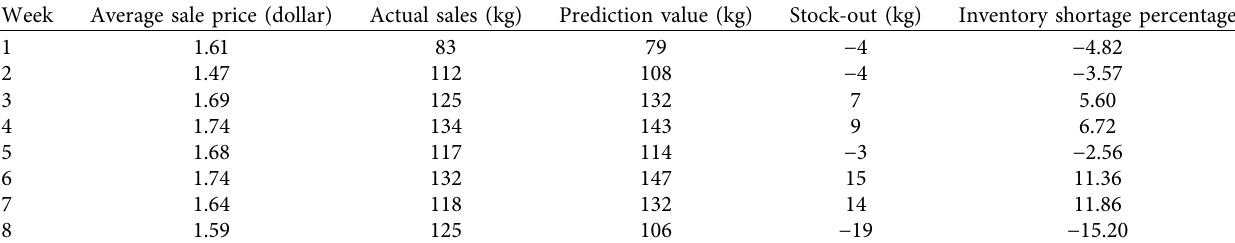
Table 5: Actual sales and forecast value of online consumption demand of peanut in 8